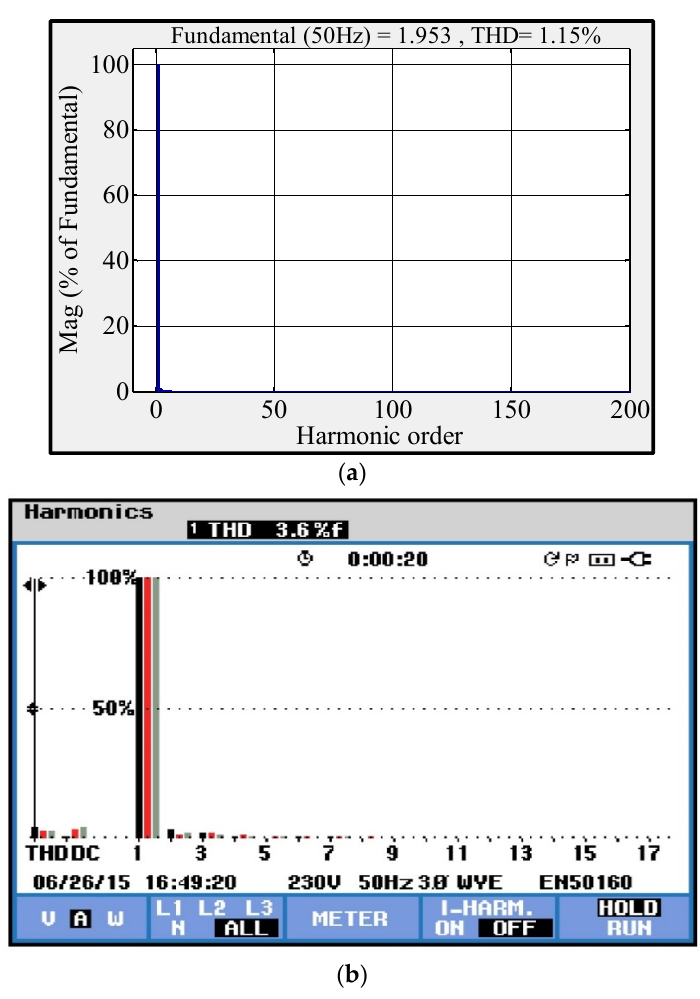
Figure 26. THD for the phase current of the three-phase inverter with RL load for ( a ) simulation and ( b ) experimental.